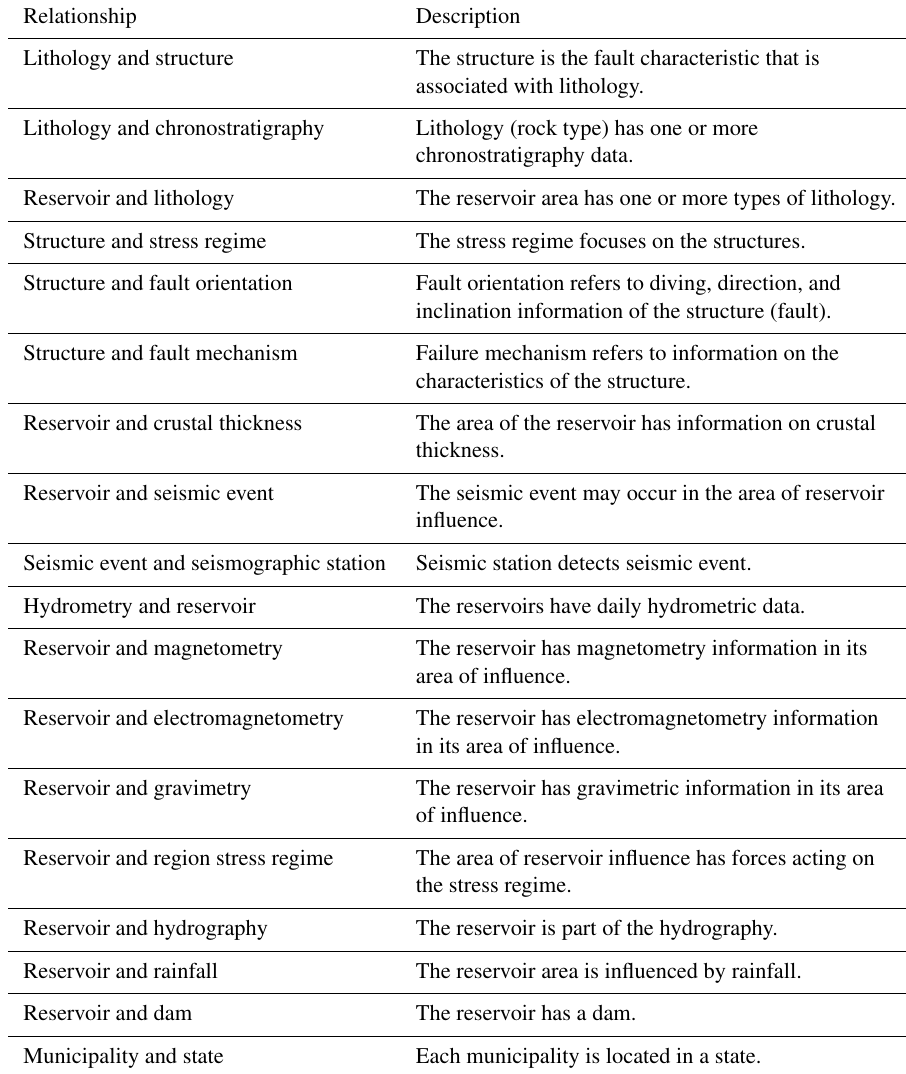
Table 1. Explanation of the OMT-G model for the reservoir-triggered seismicity